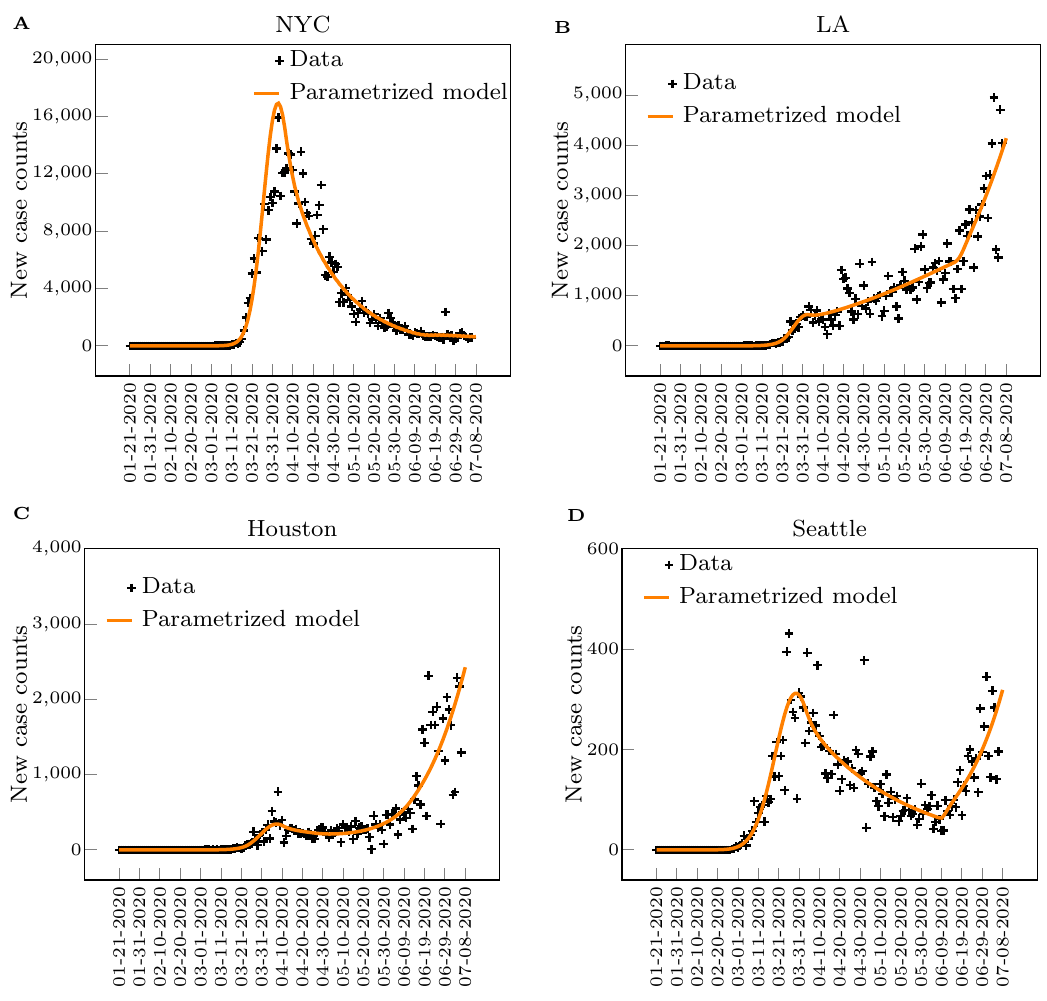
Figure 2. New case counts from January 21, 2020 to July 8, 2020 in four Metropolitan Statistical Areas within the US. Plus signs are daily new case counts reported by local health administrations. The solid line is the daily new cases obtained by integrating Eq. (2) after parametrization of the model, which was deemed to be sufficient to reproduce the trends in new daily case report 23